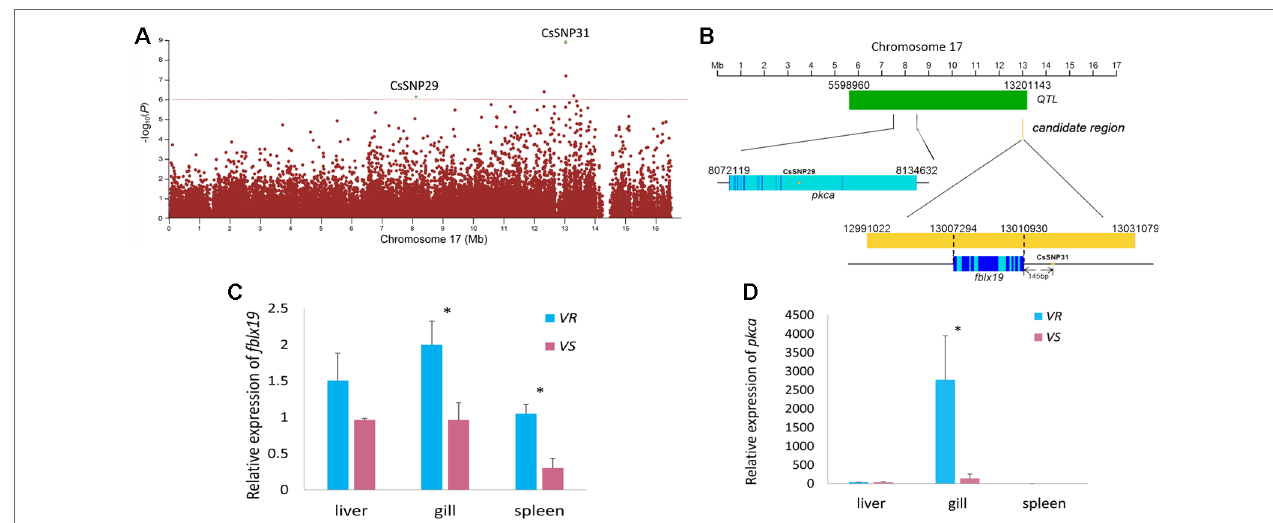
FiGURE 3 | Genome-wide association study (GWAS) and Fst and nucleotide diversity filtration identified fblx19 and pkca genes that are related to the disease resistance on Chr 17. (A) Regional Manhattan plot for Chr 17. The red line indicates the significance thresholds (−log 10 p = 6). (B) The genomic positions of the GWAS-SNPs, fblx19 and pkca gene. Dark blue, light blue, yellow and green bar represents exon, intron, candidate regions, and the disease resistance quantitative trait locus (QTL) previously identified (Dai et al., 2017), respectively. (c , D) Relative messenger RNA (mRNA) expression of fblx19 and pkca gene in the V. harveyi - susceptible (VS) and V. harveyi -resistant (VR) families, detected by quantitative real-time PCR (qPCR) with β -actin gene as the internal control. The average values of three samples in each group were used to represent the expression level. Asterisks indicate significance difference ( p <